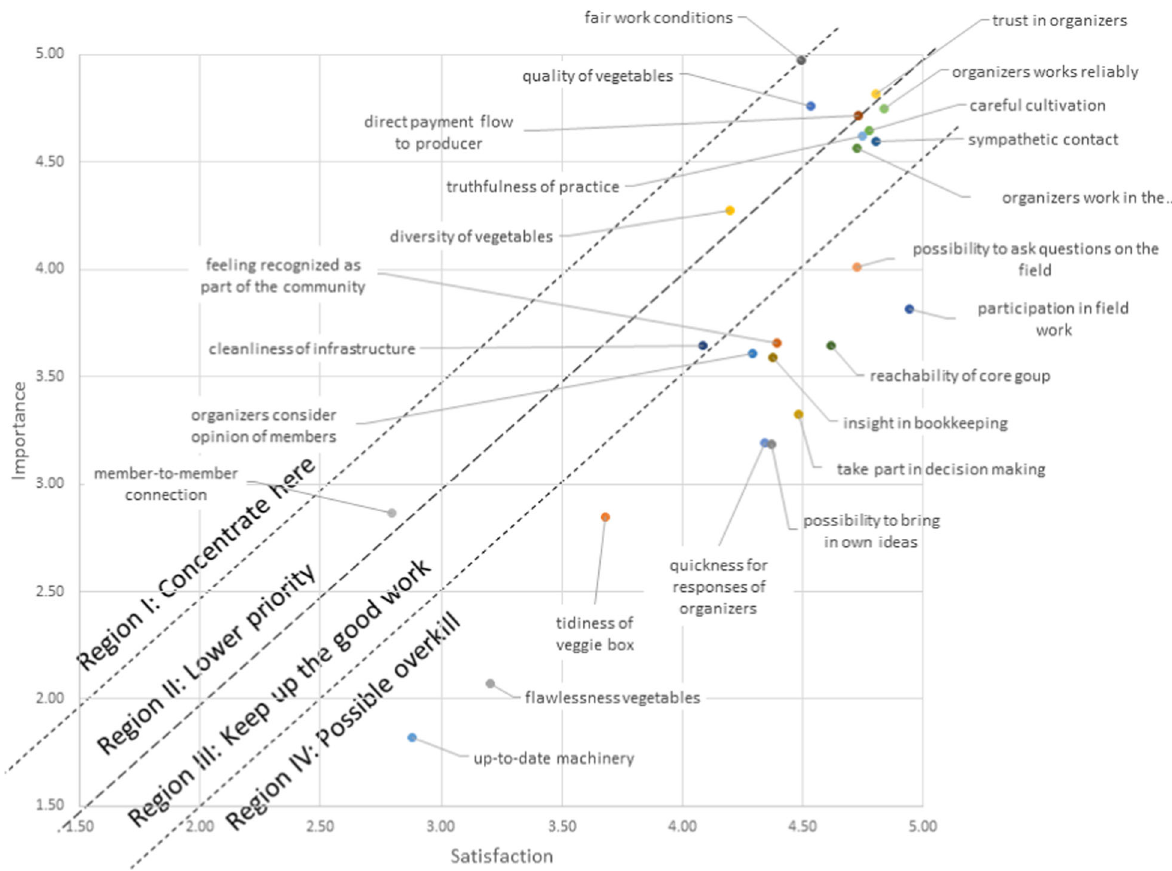
Fig. 1 Graphic presentation of the Importance-Satisfaction-Analysis (ISA) of current CSA members as performed by Galt et al. (2019). The same terminology has been applied. Region I contains the aspects of CSAs that haven rated higher in importance than satisfaction (difference of min. 0.5 points) indicating that there are open expectations, which have not yet been met. Region II indicates similar aspects but the difference between importance and satisfaction is <0.5 points. Region III describes aspects which work well satisfaction is <0.5 above the importance. All aspects which have been rated higher in satisfaction than importance by at least 0.5 points are in region IV indicating a disparity in the relevance of the particular aspect between organisers and members and shows where too much energy may have been invested by organisers clearly exceeding the members ’